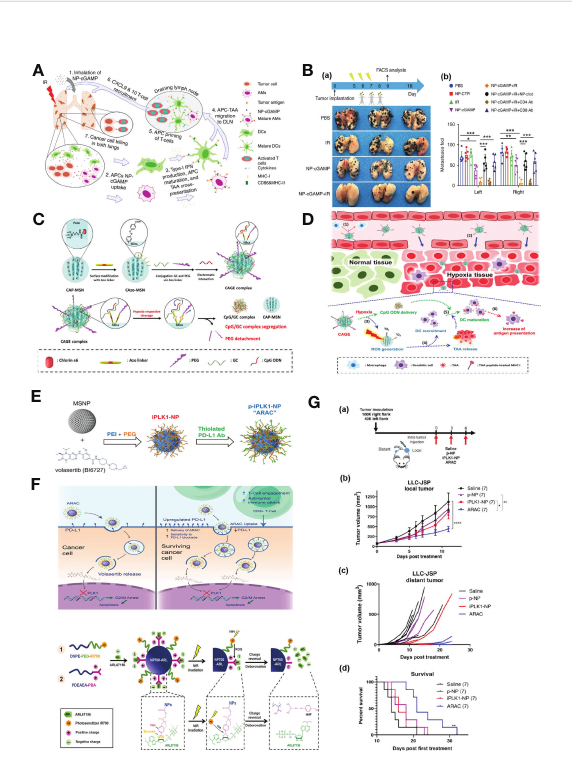
FIGURE 5 Nanotechnology enhances immune responses. (A) The mode of action of the inhalable NP-cGAMP for enhancing antitumor immunity against lung metastases (96). Adapted with permissions from ref (96). Copyright 2019, Springer Nature. (B) , (a) The mice (n = 6/group) were sacri fi ced on day 18 and representative lungs (n = 3) from the treatment groups were displayed. (b) Both lungs were examined under a dissecting microscope and a total of metastatic lung foci on each lung were counted (96). Adapted with permissions from ref (96). Copyright 2019, Springer Nature. (C) A synthetic scheme of CAGE complex (97). (D) Mode of action of CAGE in vivo (97). Adapted with permissions from ref (97). Copyright 2019, American Chemical Society. (E) Synthesis scheme of PD-L1 antibody conjugated NP for delivering PLK1 inhibitor volasertib (98). (F) Proposed mechanism of action of ARAC nano construct (98). Adapted with permissions from ref (98). Copyright 2022, Springer Nature. (G) , (a) 100,000 LLC-JSP cells were injected in right fl ank and 40,000 cells were injected